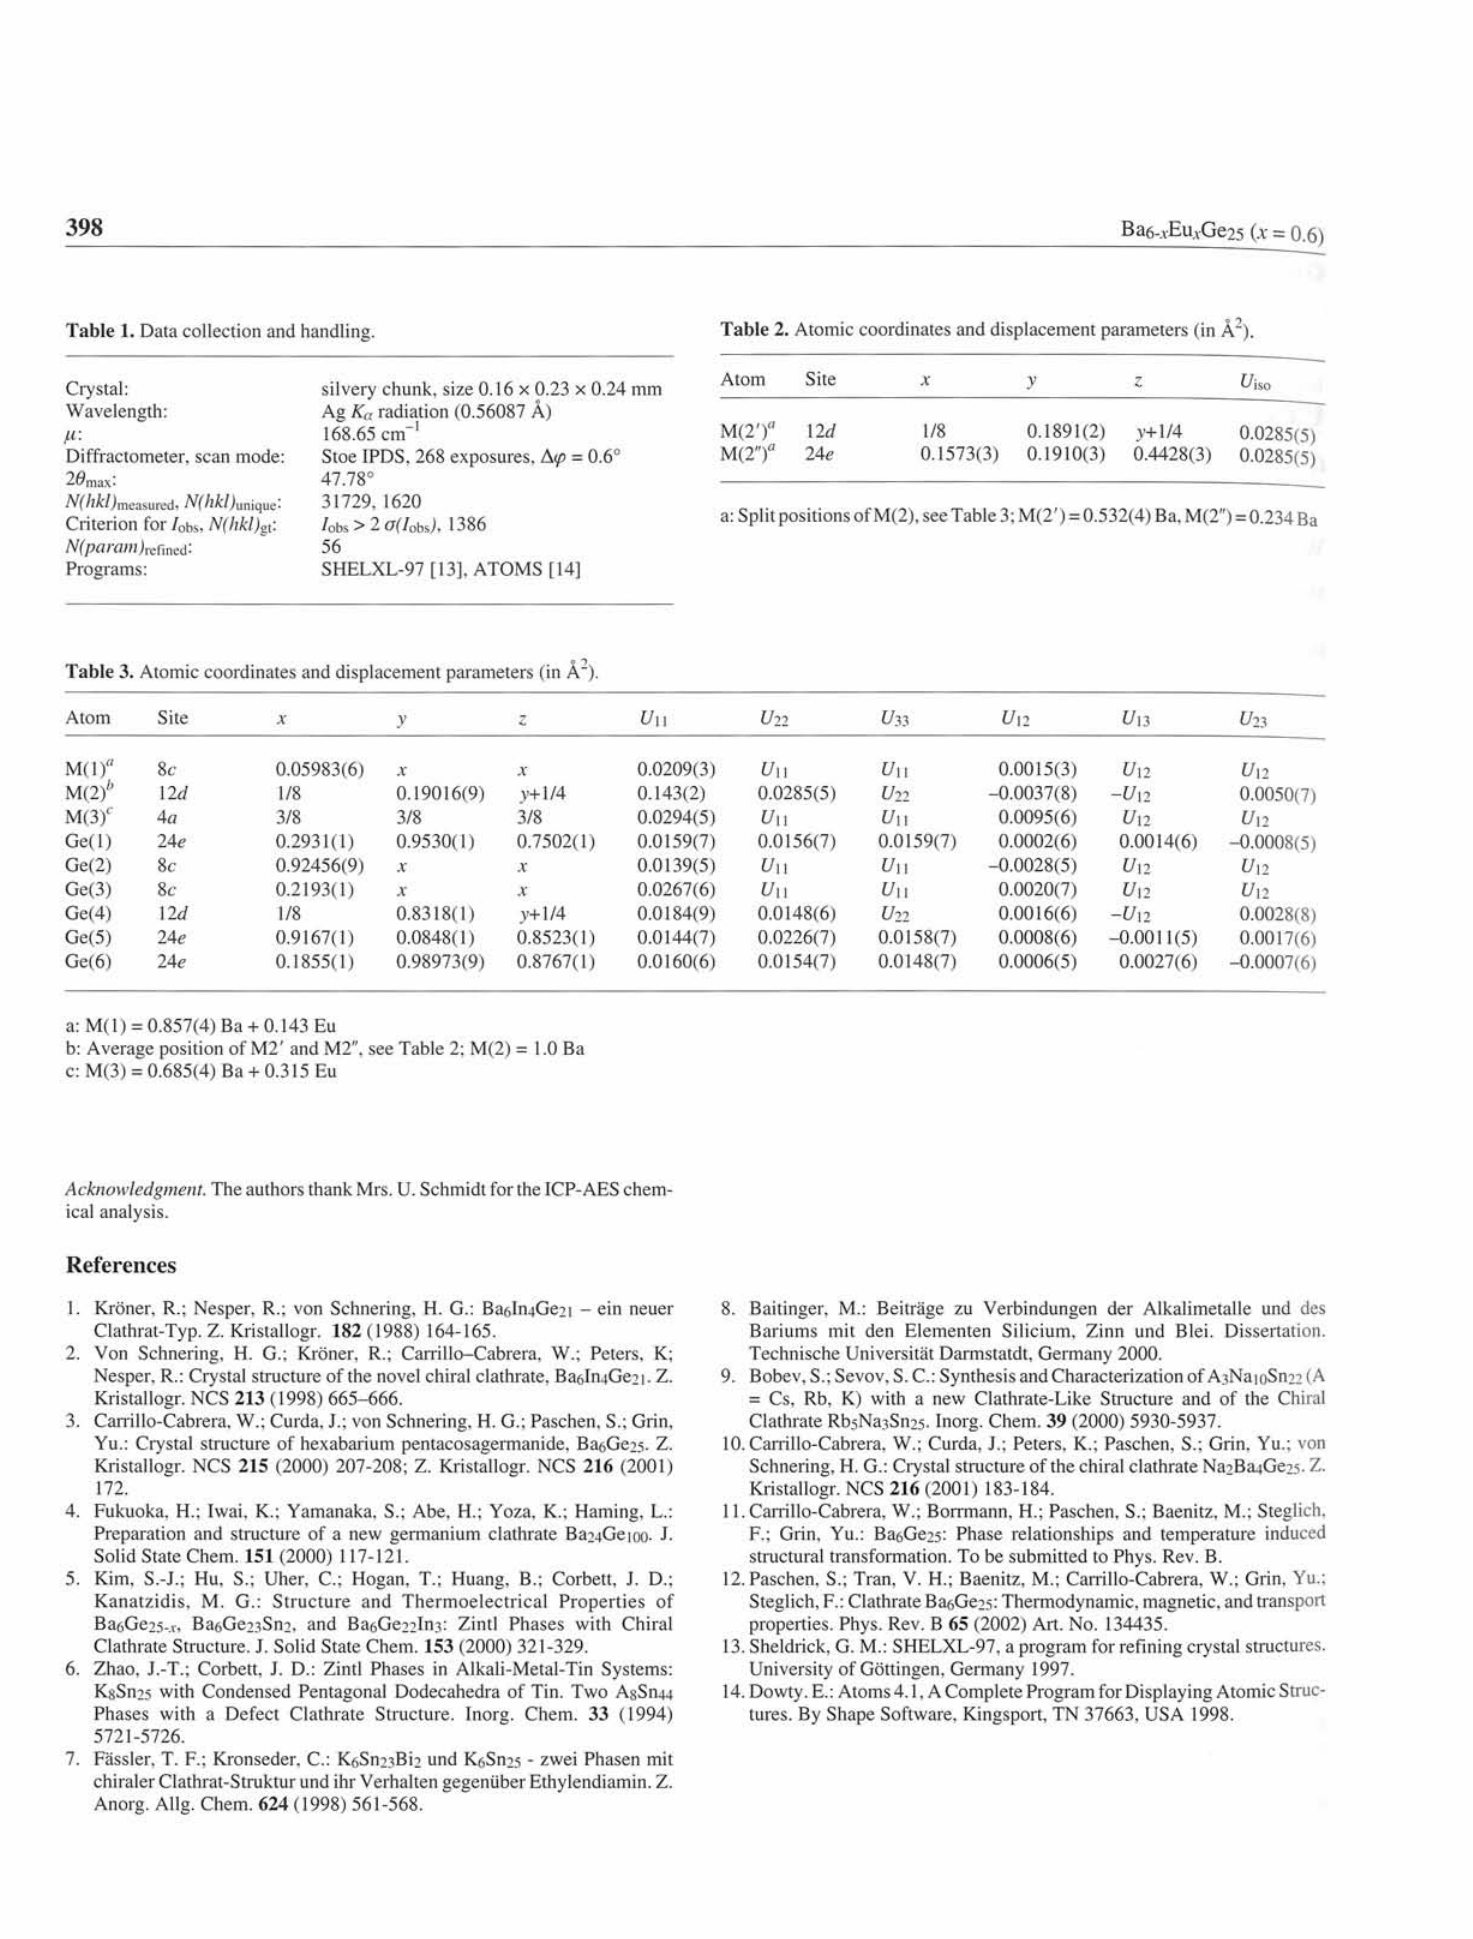
Table 1. Data collection and handling.